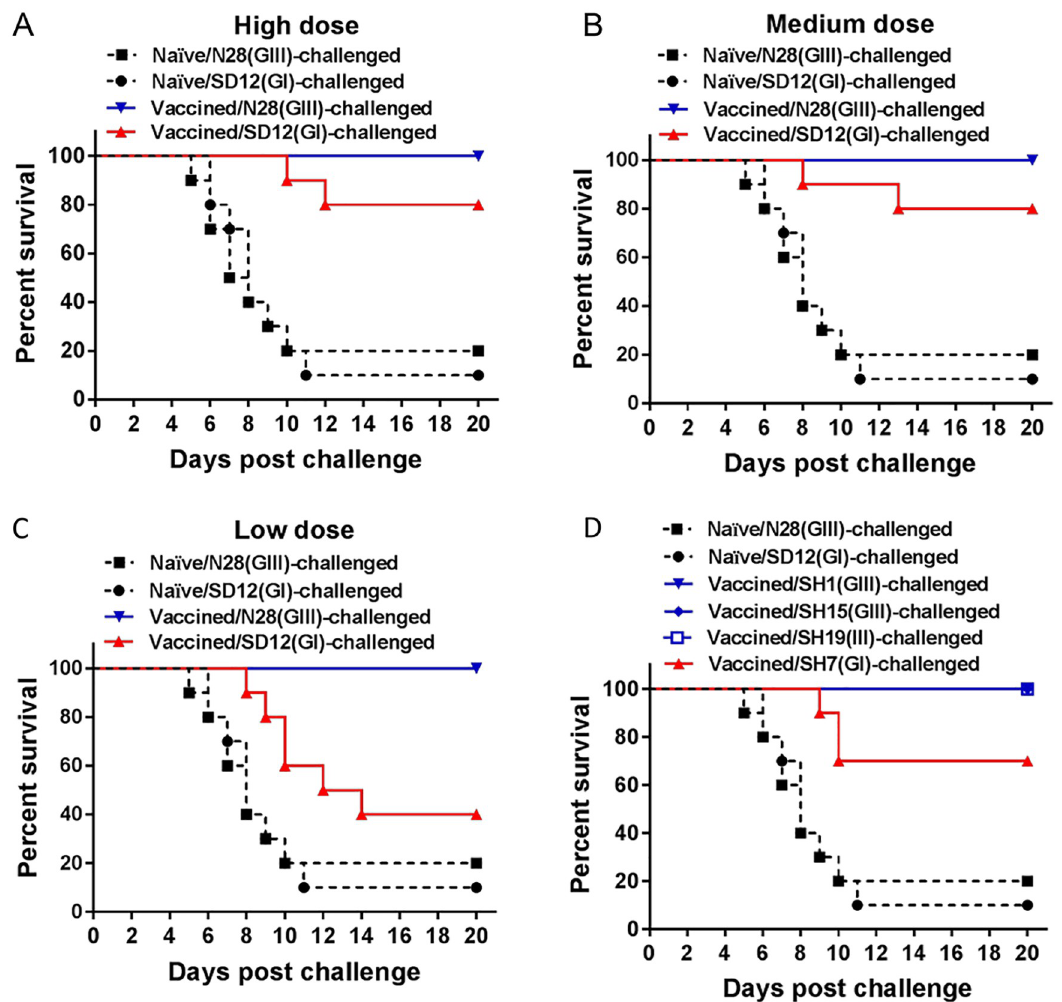
Fig 3. Protective efficacy of a N28(GIII)-inactivated vaccine. Mice ( n = 10) were mock-vaccinated (Na ï ve) or immunized with N28(GIII)-inactivated vaccine at high (10 5 PFU) dose (A), at medium (10 4 PFU) dose (B and D), and at low (10 3 PFU) dose (C) and challenged with the indicated JEV